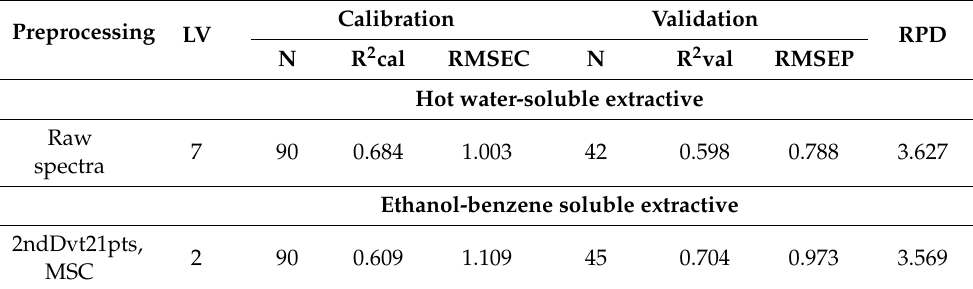
Table 2. Calibration and validation model for extractive content of ebony wood.